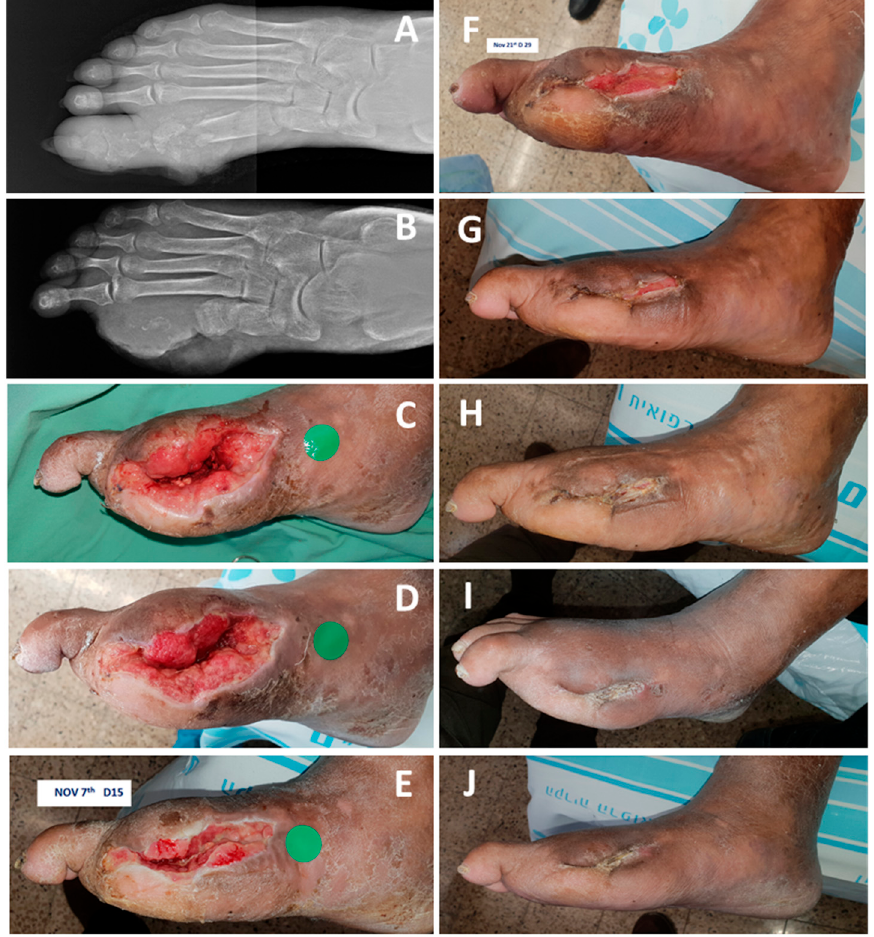
Figure 4. Closure of a wound in a non-insulin-dependent diabetes mellitus (NIDDM) patient (Case Report 2). ( A )The patient suffered from osteomyelitis of the first ray in the right leg. ( B ) The patient underwent an amputation of the first ray on 9th October 2019. ( C ) After five days of standard of care (SOC) and two vacuum-assisted closure (VAC) sessions, COD was applied. ( D ) Four days after COD treatment the wound seemed to respond favorably to COD and same treatment was continued. ( E ) Fifteen days of COD treatment. ( F ) Twenty-nine days of COD treatment. ( G ) Forty-six days of COD treatment. ( H ) Fifty-seven days of COD treatment. ( I ) After 74 days of COD treatment the wound was completely closed, and the COD treatment was stopped. ( J ) The wound remained solidly closed as seen 94 days after the commencement of the COD